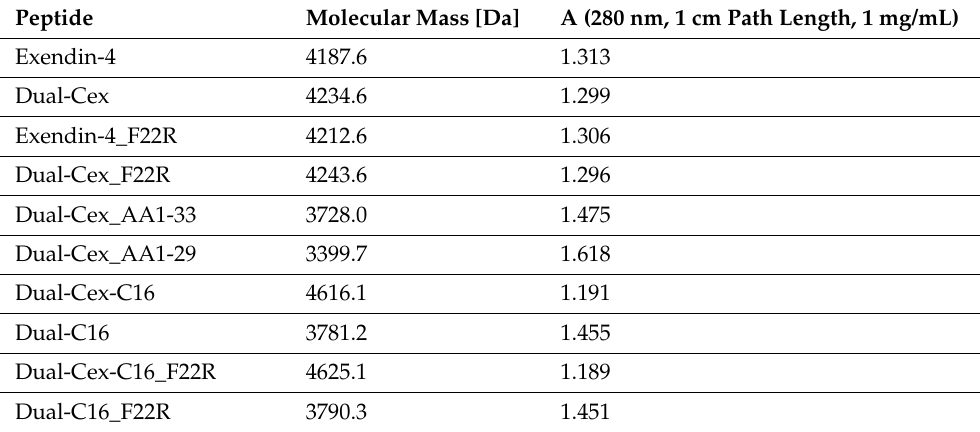
Table 1. Specific absorbance and molecular mass of the peptides calculated with the ProtParam tool [19] from their amino acid sequences including the alkyl chain if